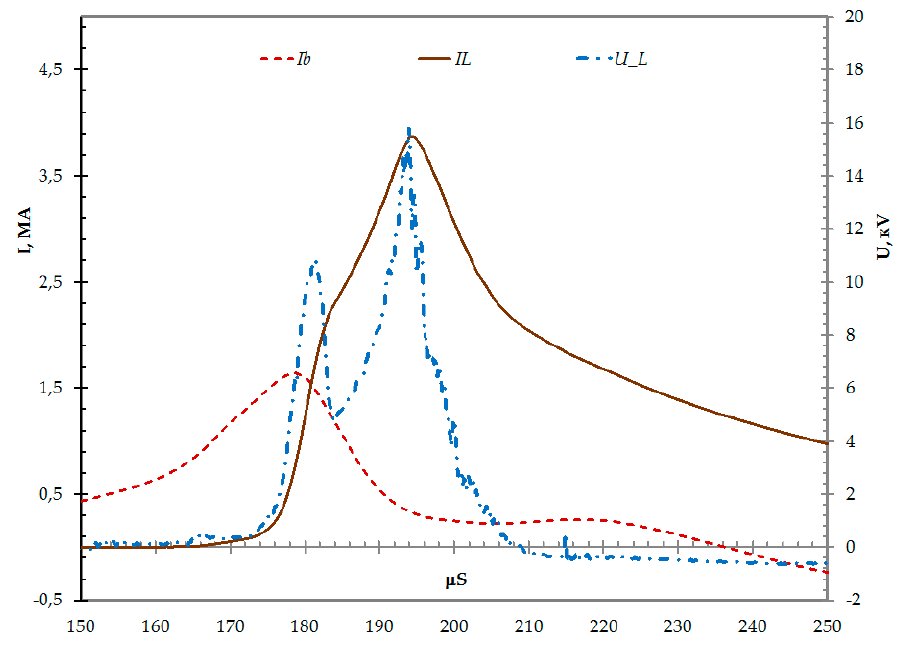
Figure 9. Oscillograms of current and voltage pulses.